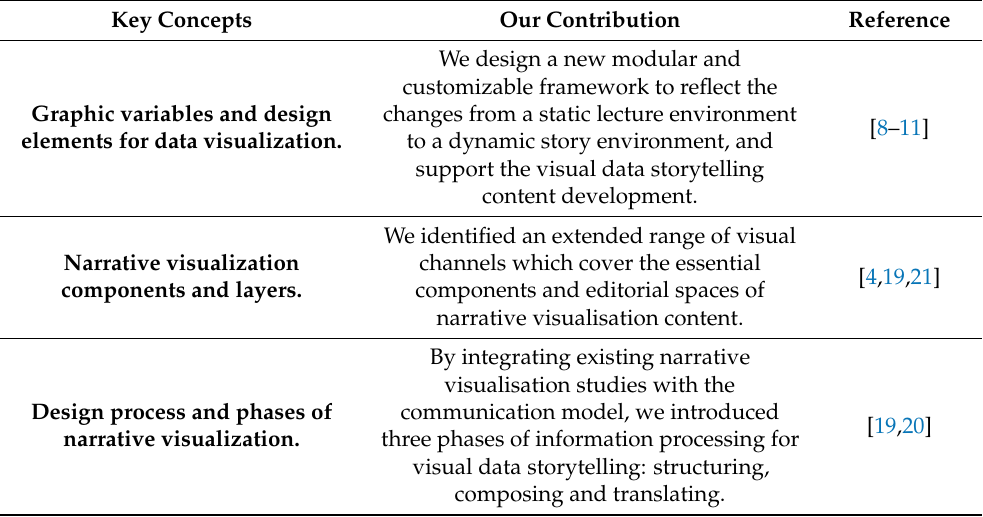
Table 1. Our extension of existing research works in data visualisation, narrative visualisation, and data storytelling.